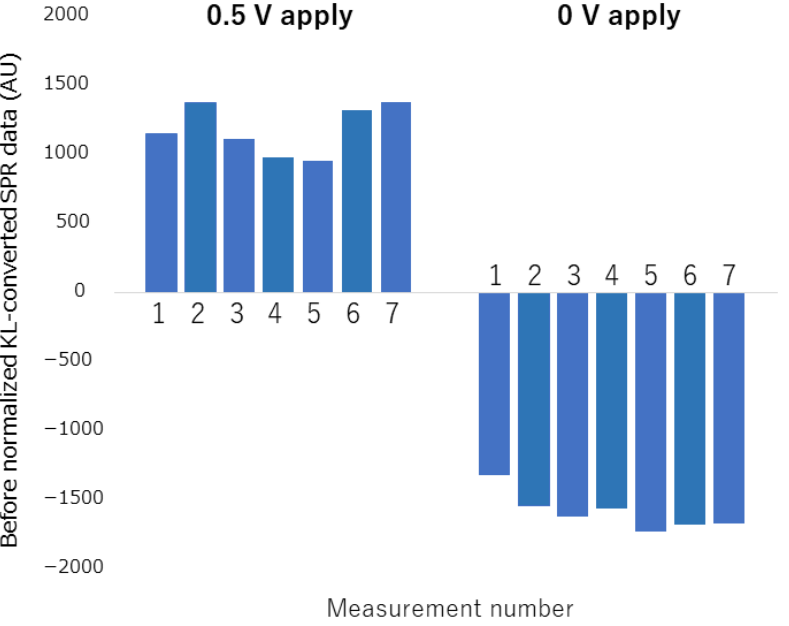
Figure 7. KL-converted SPR measurement data before normalization when repeated measurement is performed under the same voltage application condition